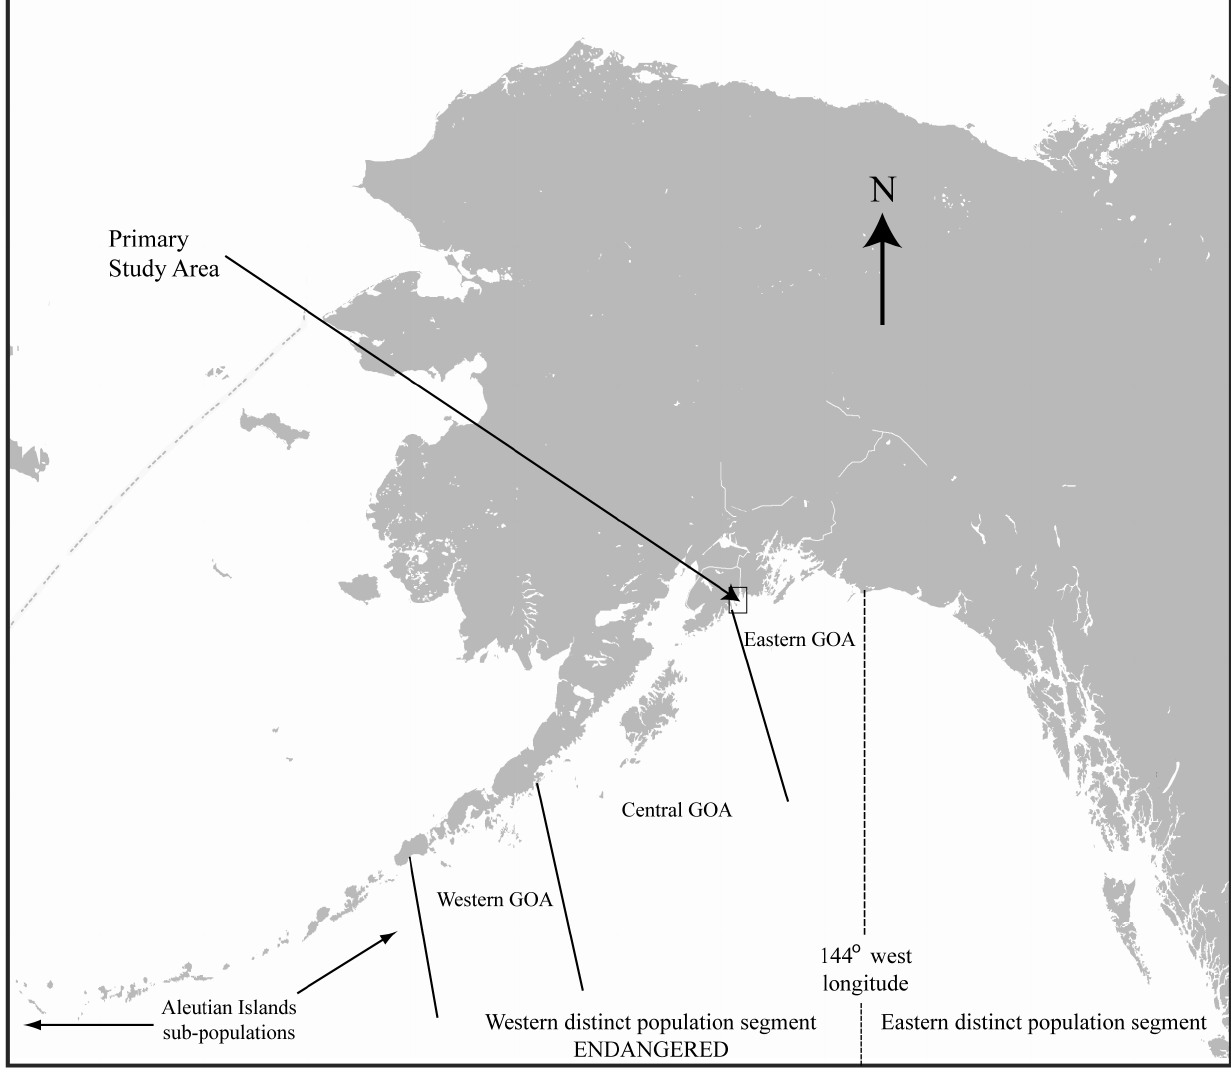
Figure 1. Map of Alaska showing the delineation between the western (endangered) and eastern distinct population segments of Steller sea lions and the primary area of study for this research in the eastern Gulf of Alaska.